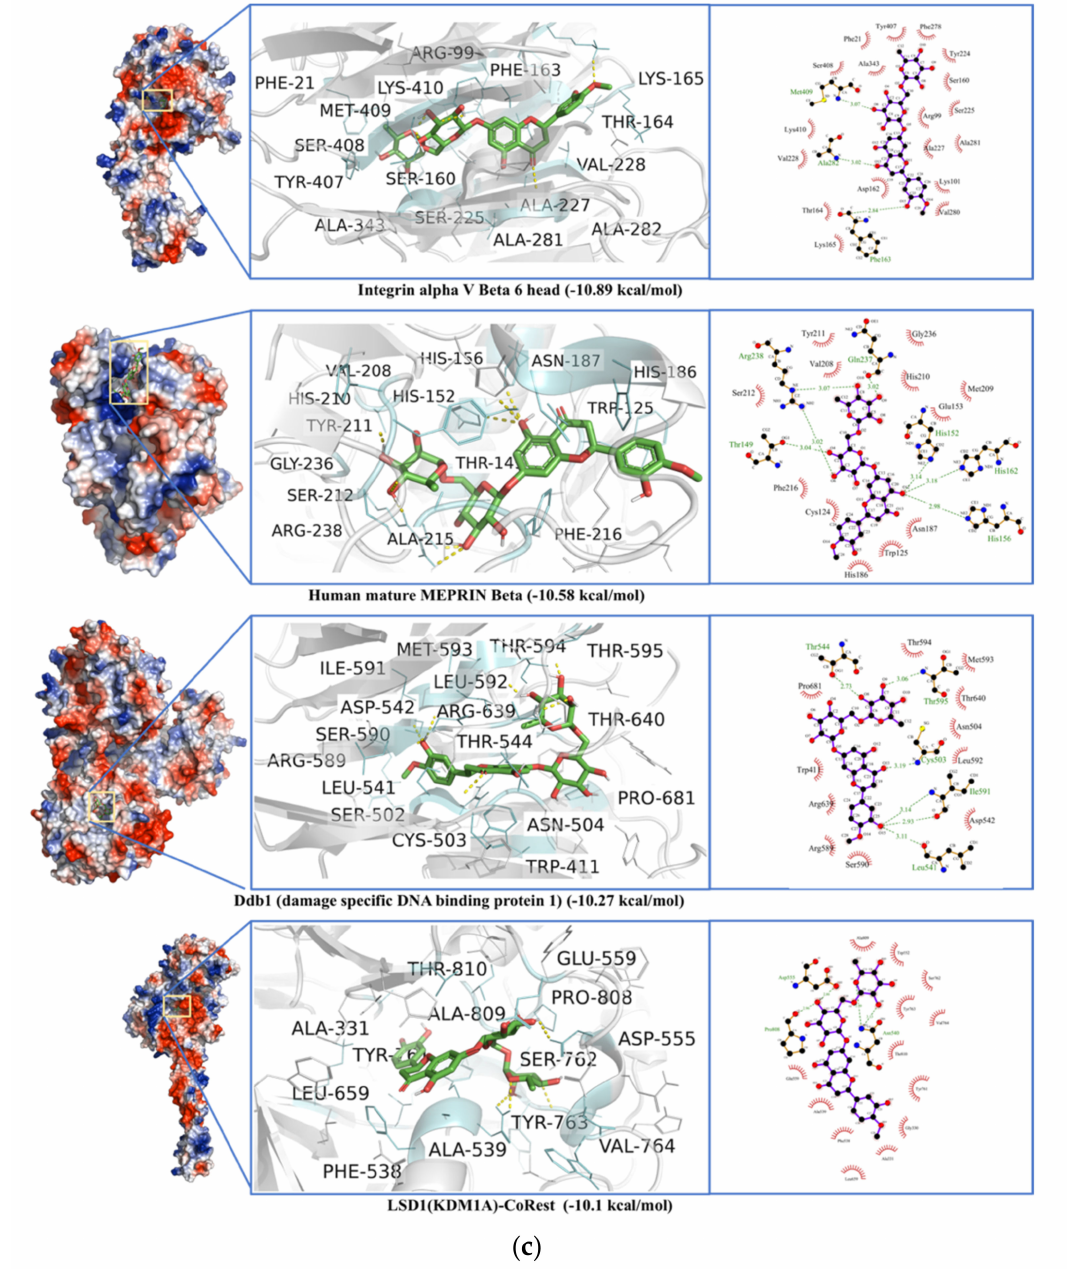
Figure 13. ( a ) Glycyrrhizin non-specific interactions with human proteins including Ddb1 (damage specific DNA binding protein 1), Human RECQ-like helicase, PI3KA (transferase), and Human OSC (an isomerase). ( b ) Baicalin non-specific interactions with damage specific DNA binding protein 1 (Ddb1), Camp-dependent protein kinase a (catalytic alpha subunit), Human focal adhesion kinase, and Human MTH1 (a hydrolase). ( c ) Hesperidin non-specific interactions with Integrin alpha V Beta 6 head, Human mature MEPRIN Beta (a hydrolase), Ddb1 (damage specific DNA binding protein 1), and LSD1(KDM1A)-CoRest (a transcription